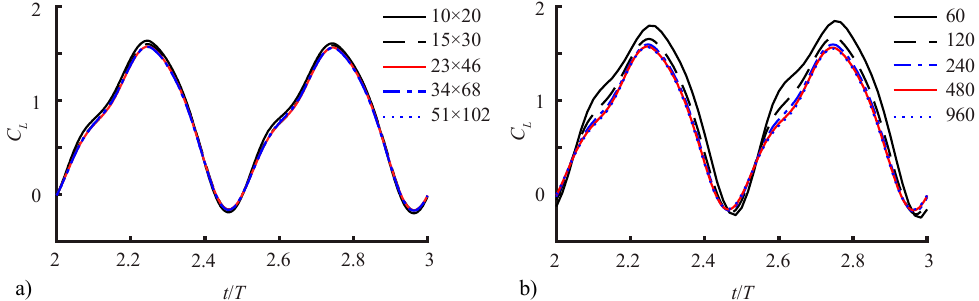
Figure 3. Time history of the lift coefficient for the ( a ) spatial and ( b ) time sensitivity studies during the third flapping period. Note, all NSe results reported are from the third flapping period.